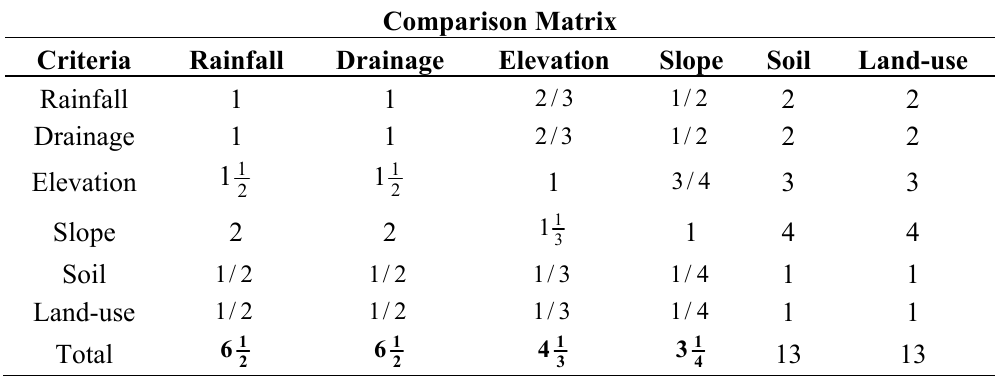
Table 3. Ranking of urban flood causing criteria to obtain the pairwise comparison